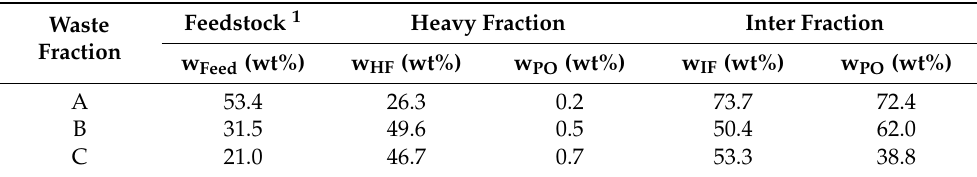
Table 12. Mass fraction of the feed (w Feed ), heavy (w HF ) and inter fraction (w IF ) and corresponding polyolefin fraction(w PO ) of the jig for feedstocks with high (A), middle (B), and low (C) initial polyolefin share.